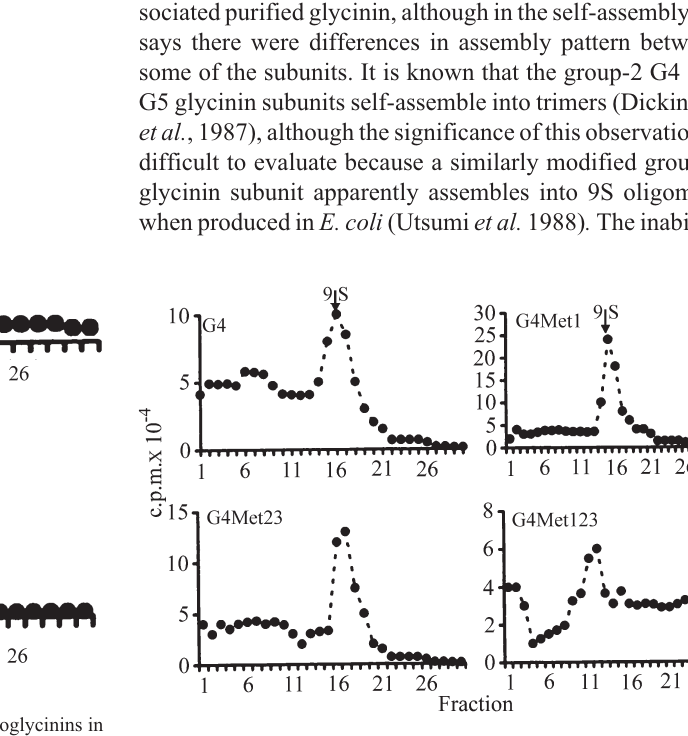
Figure 6 - Self-assembly of pSP65/248 , pSP65/Metl , pSP65/Met2,3 , pSP65/248 Metl,2,3 . Radioactive H 3 -Leu labeled proglycinins were syn- thesized in vitro using pSP65/248, pSP65/Metl , pSP65/Met2,3 , pSP65/248 Metl,2,3 . They were incubated in the translation mixtures for 30 h 250 °C to promote self-assembly and then analyzed by sedimentation in sucrose